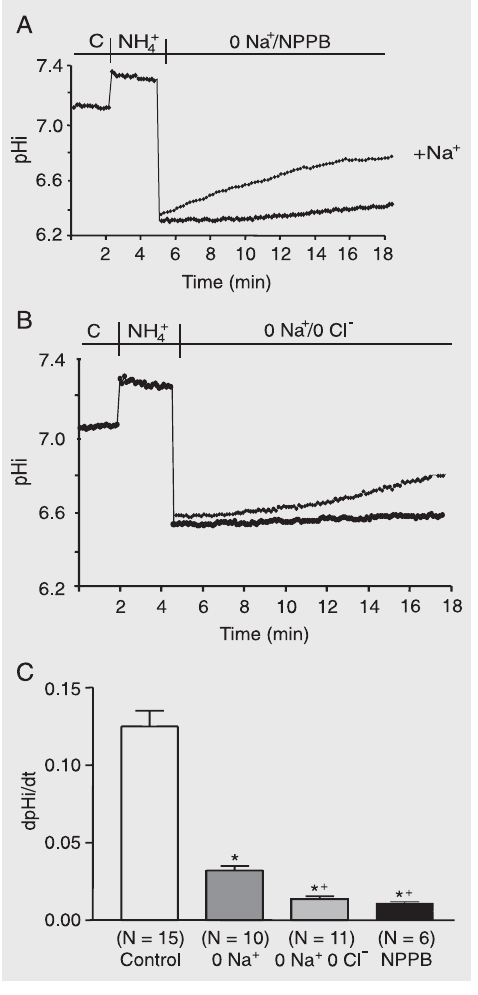
Figure 1. Records of cell pH un- der control (C), ammonium pulse (NH 4 ) and experimental condi- tions in MDCK-C11 cells. A , Su- perfusion with 0 Na + Ringer so- lution (solution 3) + 10 µM NPPB. For comparison, + Na + was superfused with Na + Ringer (solution 1). B , Superfusion with 0 Na + /0 Cl - Ringer solution (so- lution 5) compared to 0 Na + alone (solution 3). C , Mean ini- tial rate of pHi recovery follow- ing acute intracellular acidifica- tion in MDCK-C11 cells. Each bar represents the mean ± SEM rates of cell pH recovery (dpHi/ dt, pH units/min) under different experimental conditions (control Na + Ringer, 0 Na + Ringer, 0 Na + /0 Cl - Ringer, and 0 Na +